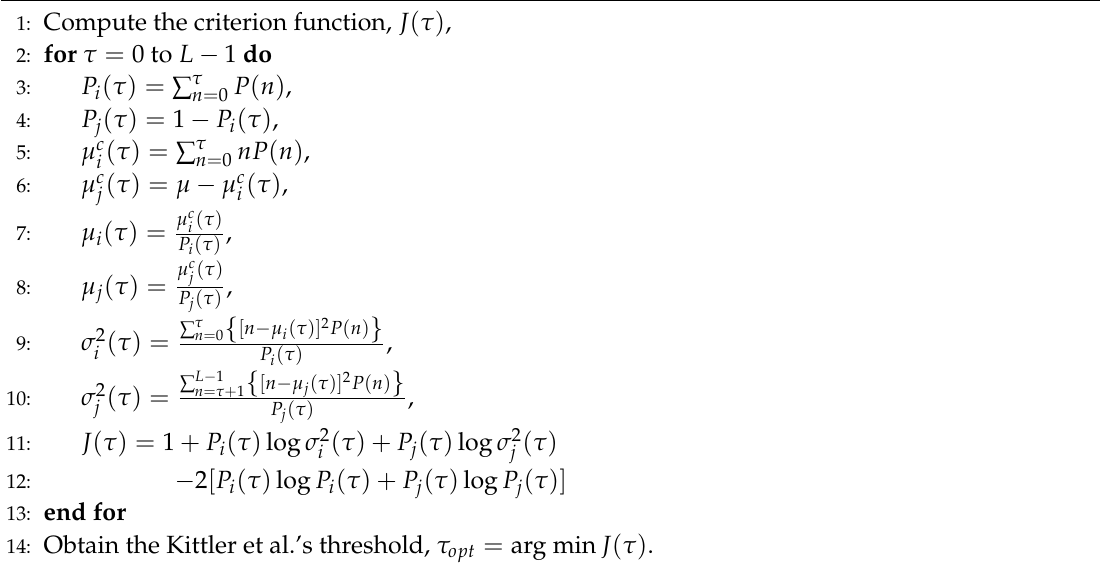
Algorithm 3 The Kittler et al.’s